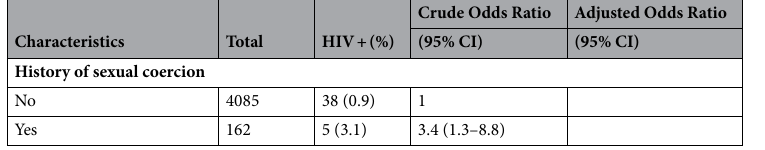
Table 4. Univariate and multivariate analysis of risk factors for HIV infection among the newly inducted army conscripts that entered into military service in November 2018. The number of HIV + individuals and in the total column in each characteristic was based the response of study